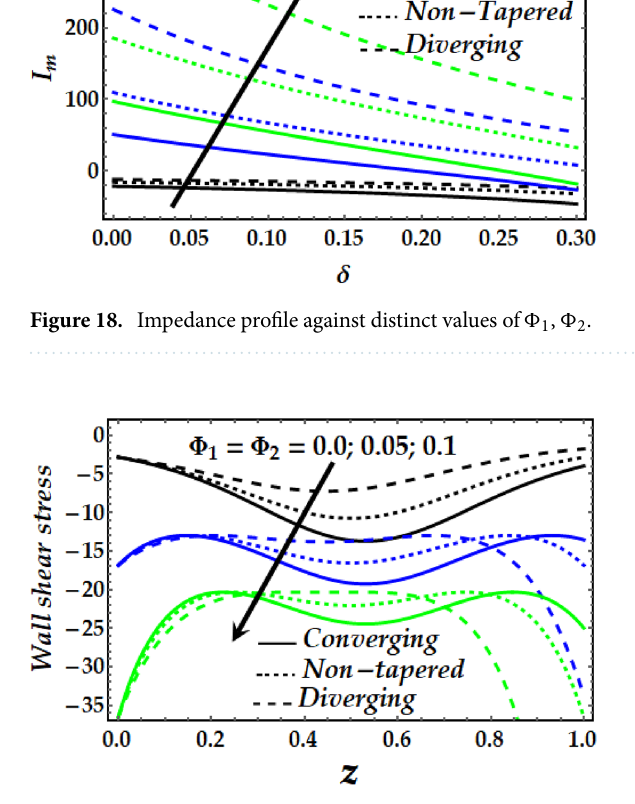
Figure 19. Wall shear stress against distinct values of (cid:31) 1 , (cid:31) 2 .